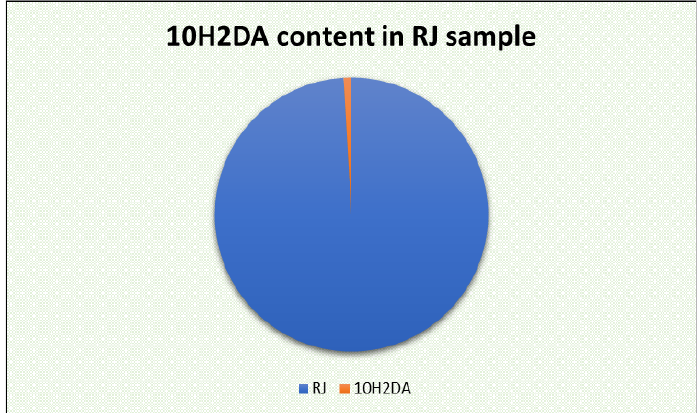
Figure 1. Content of 10H2DA in RJ sample originated from Serbia.